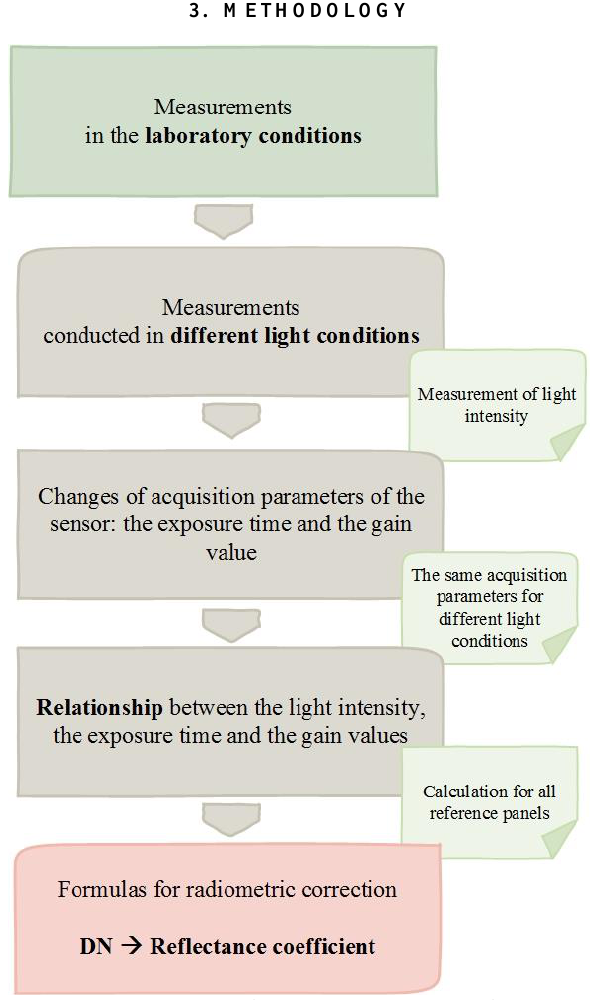
Figure 5. Methodology for determining spectral reflectance coefficients from hyperspectral image without camera